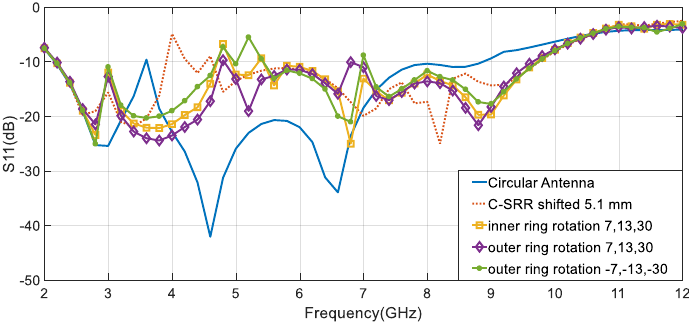
Figure 35. S 11 for multiple C-SRR variations.